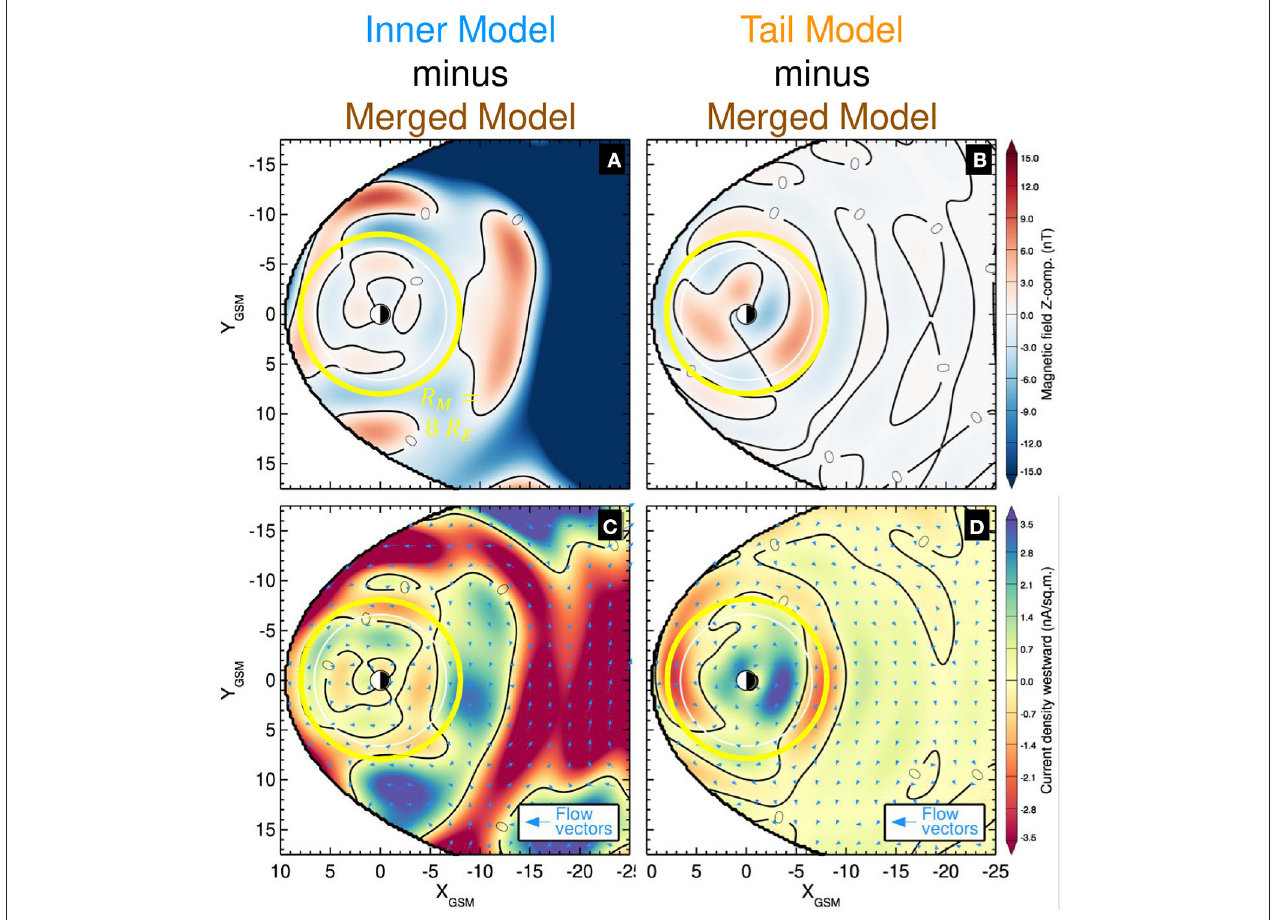
FIGURE 5 | The Merged Model differences. The difference between Inner / Tail and the Merged Model 2D equatorial distributions from Figure 4 . The format is the same as Figure 4 but the range on the color bars has been halved to emphasize the